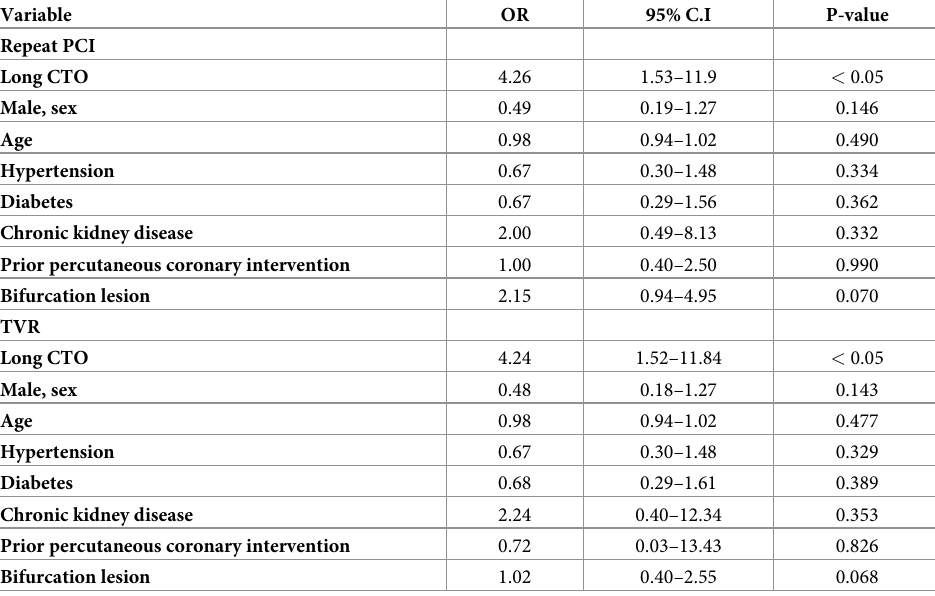
Table 4. Multivariate analysis of risk factor for repeat PCI and